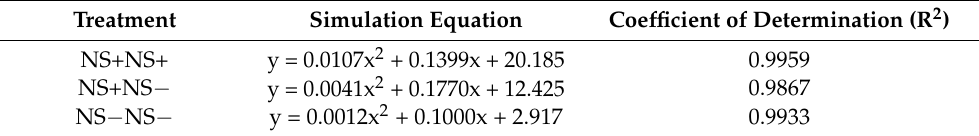
Table 1. Dynamic models for clonal growth of Kentucky bluegrass under different water treatments.